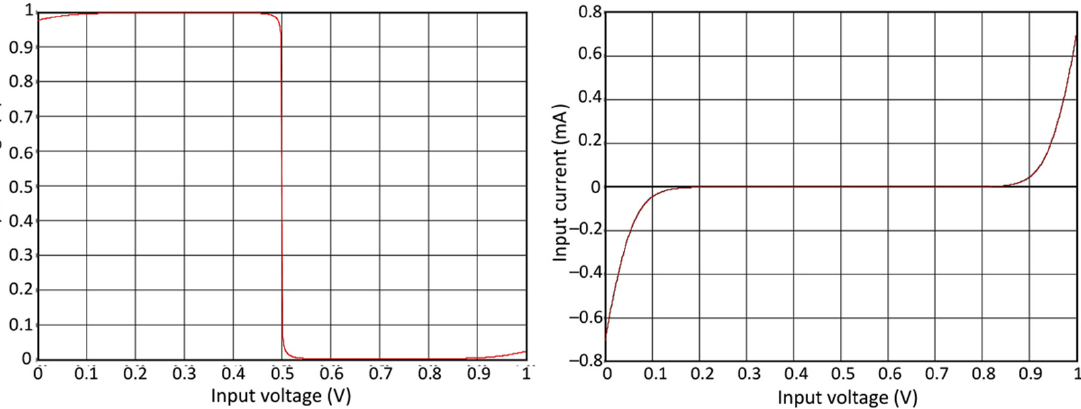
Figure 4. Transfer characteristic and input current of a CBip inverter. V CC = 1 V, temperature 300 K. If the supply voltage is reduced to 0.65 V, the transfer characteristic is still acceptable, and the input current is reduced to nanoamperes—see Figure 5.